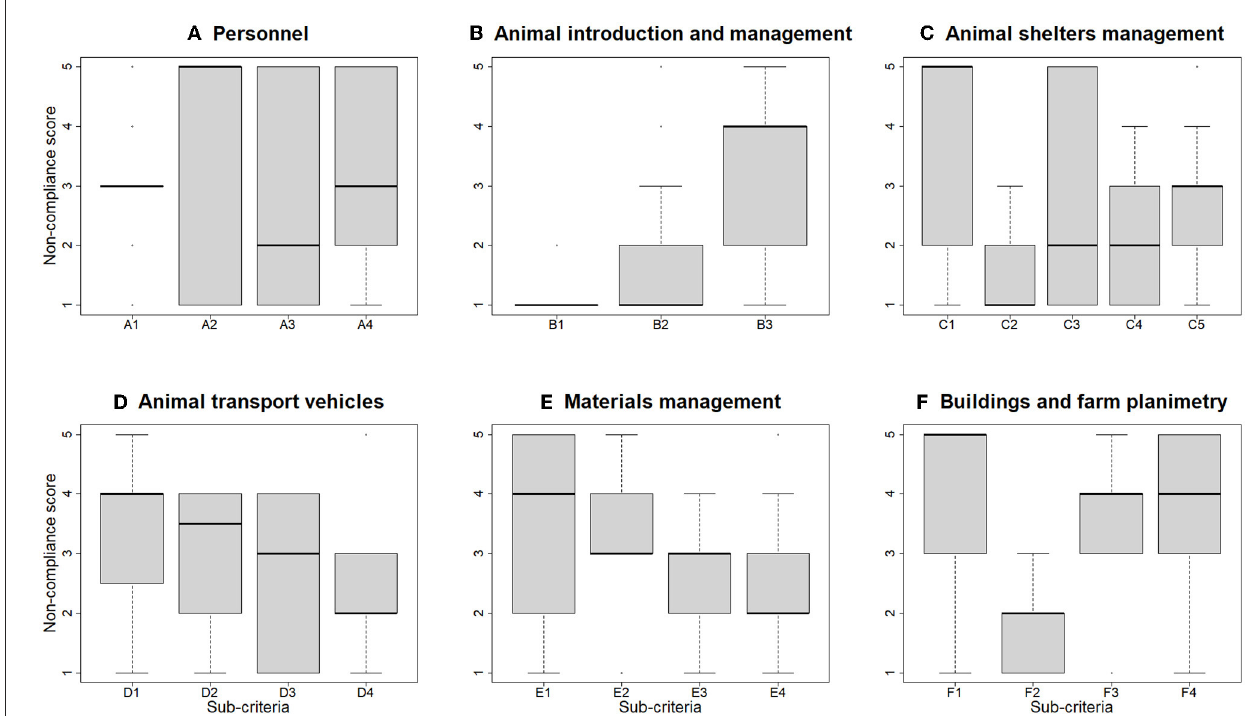
FIGURE3 Boxplot of the distribution of non-compliance score for each sub-criterion, obtained by evaluation of 60 commercial pig farms in Italy. In the boxes, the thick horizontal line represents the median non-compliance score; the base and the top of the boxes are the first and third quartiles, respectively. Whiskers extend to a maximum of 1.5 times the interquartile range. Points represent extreme